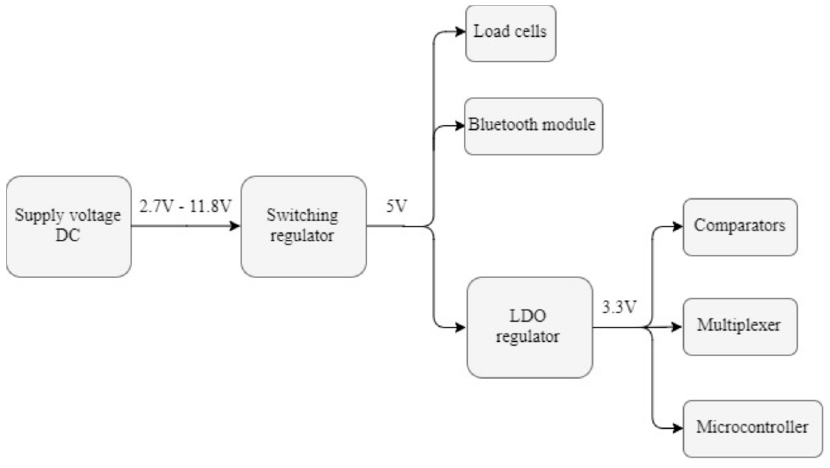
Figure 11. Structure of the power supply system.